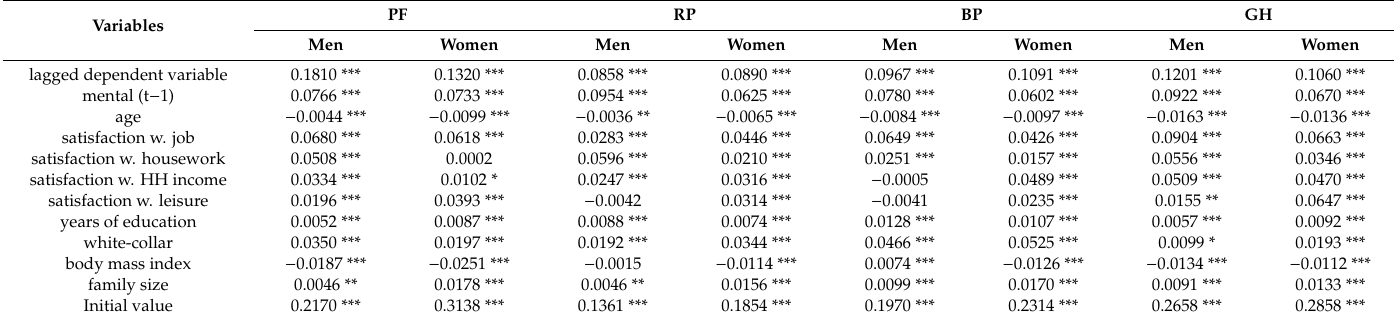
Table 5. Estimation results: average partial e ff ects of physical-related